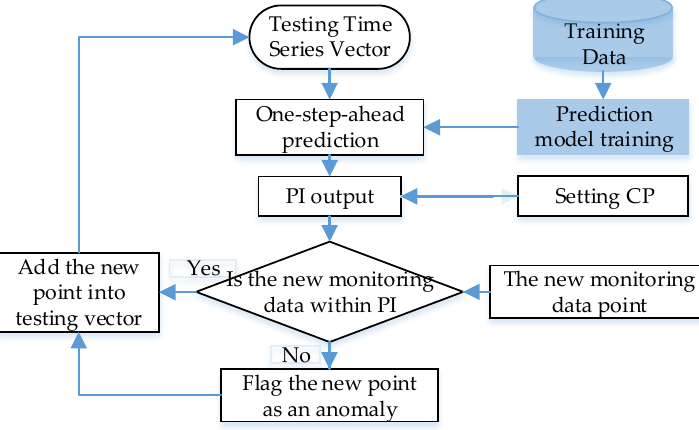
Figure 1. Anomaly detection with the probability prediction model.